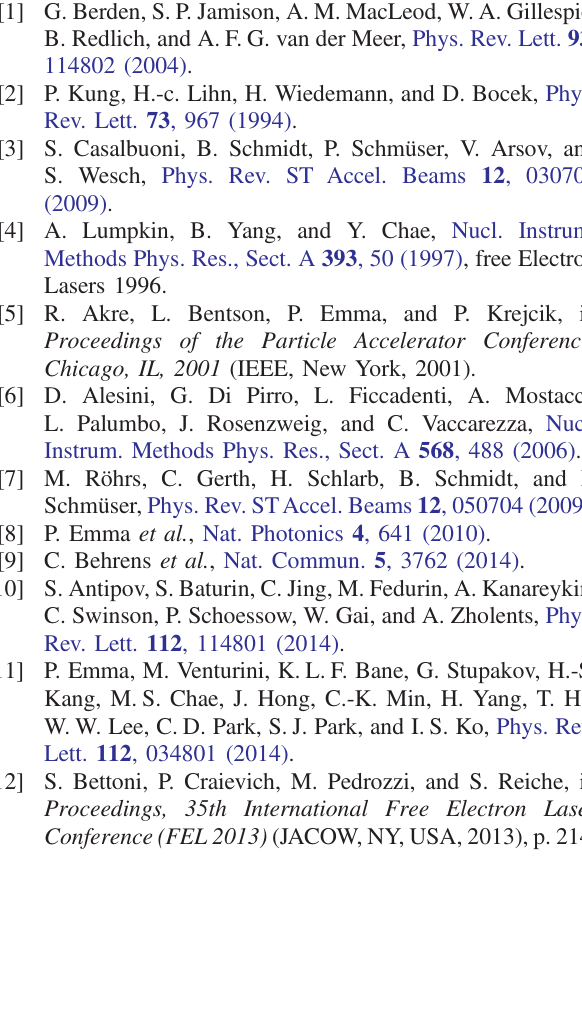
and electrons occurs only on the bunch core